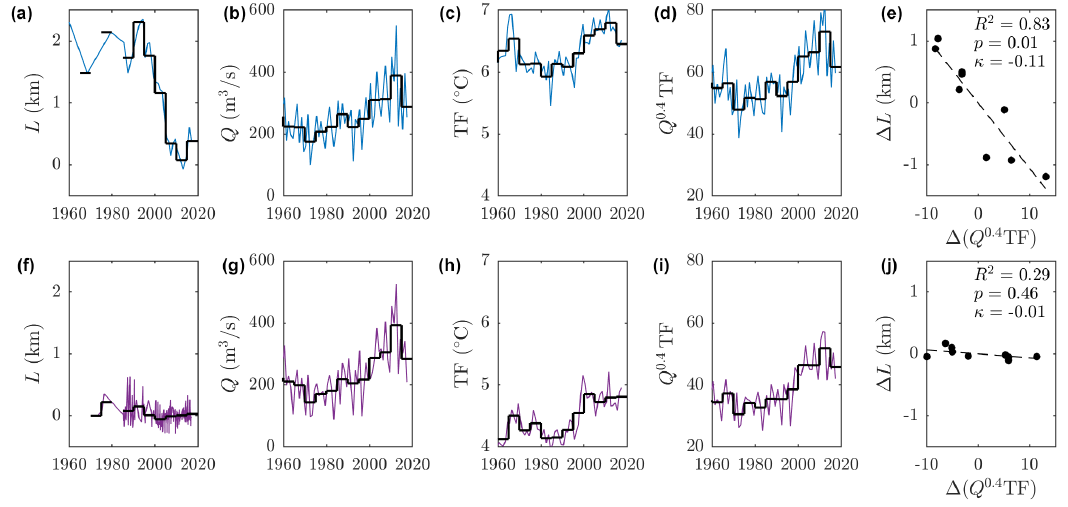
Figure 4. Example calibration of the retreat parameterization for two glaciers: Kangiata Nunata Sermia in southwestern Greenland (top row) and Store glacier in central western Greenland (bottom row). (a, f) Terminus position, (b, g) summer subglacial discharge, (c, h) ocean thermal forcing and (d, i) parameterized submarine melting. Light lines show all values in the datasets, while the heavy black lines show 5-year binning. (e, j) The 5-year binned values of parameterized submarine melt anomaly ( x axis) versus terminus position anomaly ( y axis). The text in (e) and (j) shows the correlation coefficient ( R 2 ), the significance of the regression ( p ) and the linear coefficient ( κ ).